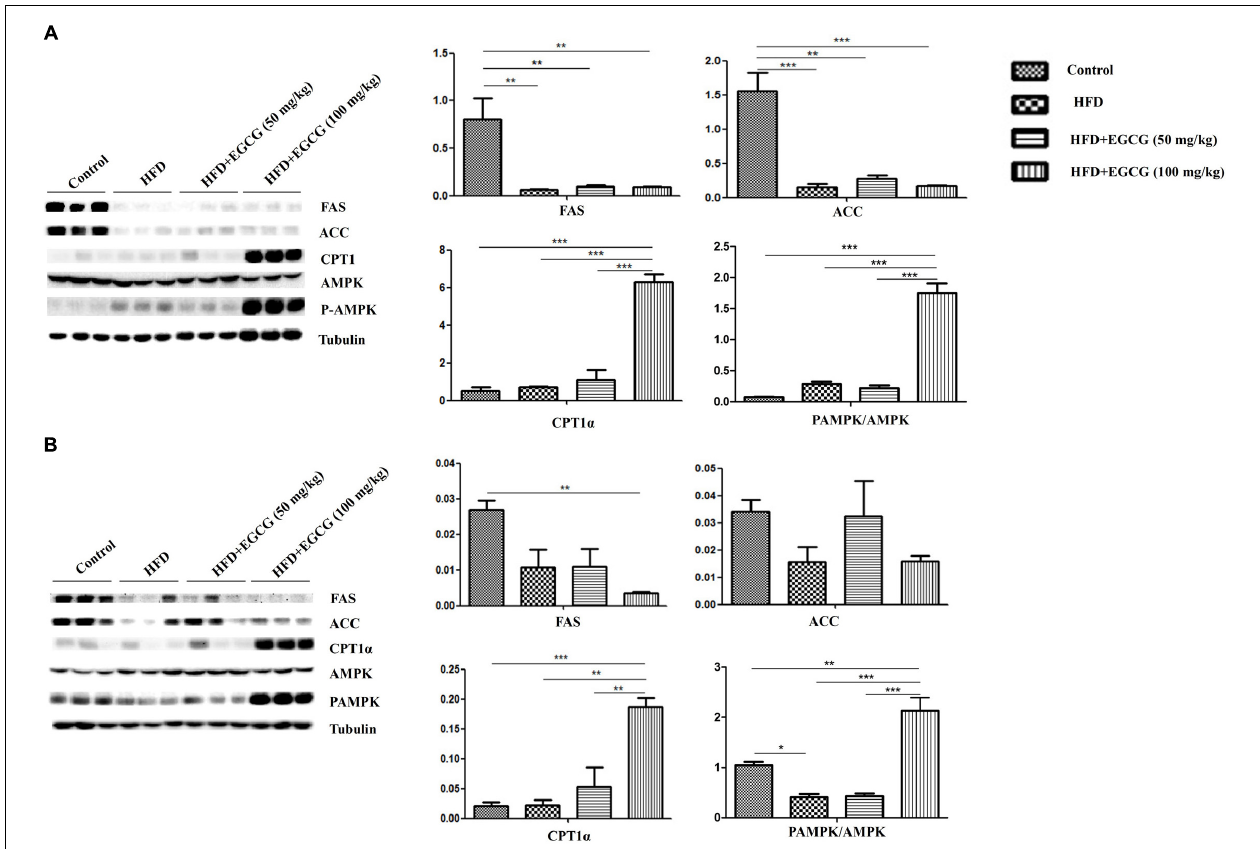
FIGURE 6 | Effect of EGCG on the expression of proteins involved in lipogenesis, oxidation, and activation of AMPK. Lysate was prepared from subcutaneous adipose tissues and epididymal adipose tissues and subjected to Western blotting analysis to detect the expression of proteins involved in lipogenesis (FAS and ACC), oxidation (CPT1 α ), and activation of AMPK in (A) subcutaneous adipose tissues and (B) epididymal adipose tissues, separately. Values are the mean ± SEM ( n = 3). ∗∗ P < 0.01; ∗∗∗ P < 0.001 between